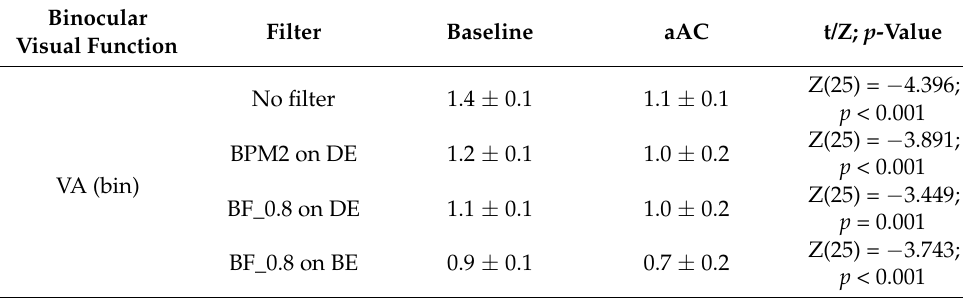
Table 2. Mean values of the binocular (bin) visual functions (Visual Acuity in decimal notation, VA; averaged Contrast Sensitivity Function, CSF; and Visual Disturbance index, VDI) under the different experimental conditions, baseline (no alcohol consumption) and aAC (after alcohol consumption) and for different filter conditions: no filter, BPM2 fog filter on dominant eye (BPM2 on DE), Bangerter foil BF_0.8 on dominant eye (BF_0.8 on DE) and BF_0.8 on both eyes (BF_0.8 on BE). Standard deviations included and statistical results (t/Z) and p -values are